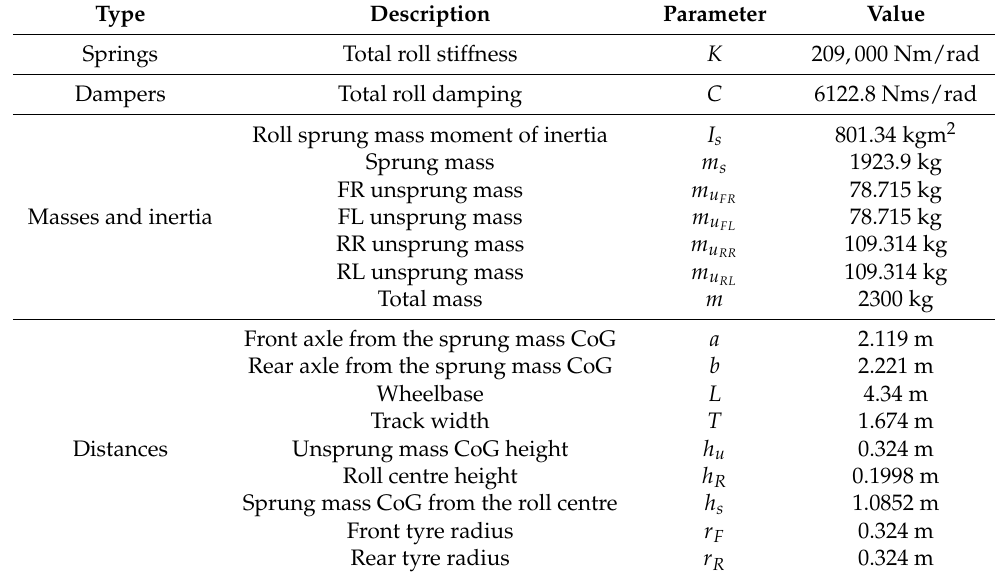
Table 1. Vehicle